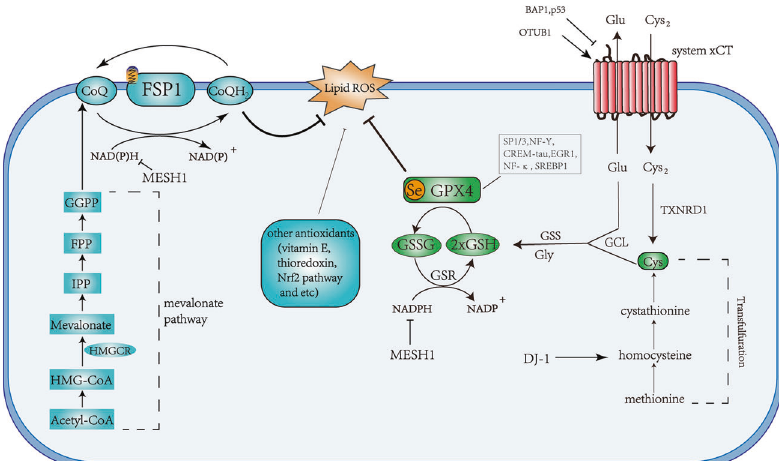
Fig. 3 Overview of the anti-ferroptosis pathway. Schematic description of the two defense mechanisms identi fi ed in ferroptosis, the GSH- dependent GPx4 pathway, and the NADPH-dependent FSP1 pathway. Glutamine (Gln); glutamate (Glu); cysteine (Cys); glycine (Gly); glutathione-disul fi de reductase (GSR); stimulating proteins 1 and 3 (SP1/3); nuclear factor Y (NF-Y); cAMP-response element modulator-tau (CREM-tau); early growth response protein 1 (EGR1); nuclear factor κ B (NF- κ B); sterol regulatory-binding element 1